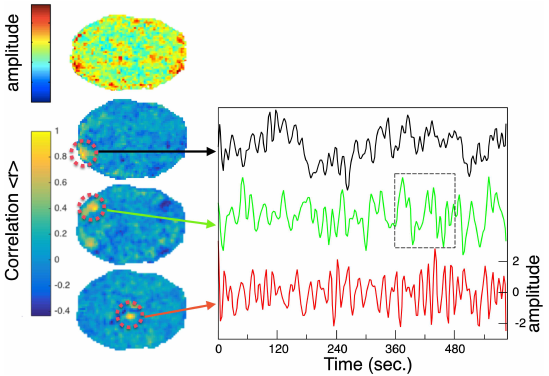
Figure 2: Right: Examples of typical BOLD time series from three selected sites in the brain. The dashed box in the middle time series indicates a portion of the signal used later in the analysis presented in Fig. 4. Left: Images correspond to a snapshot of activity amplitudes (top), the correlations between the three selected seeds (red dotted circles) and the rest of the brain (middle three images), and the corresponding brain structural slice at MNI coordinate z=10 (bottom). The MNI x, y, z coordinates are -31 -95 10, respectively, for the top trace, 43 -73 10 for the middle trace and -10 -31 10 for the bottom trace.